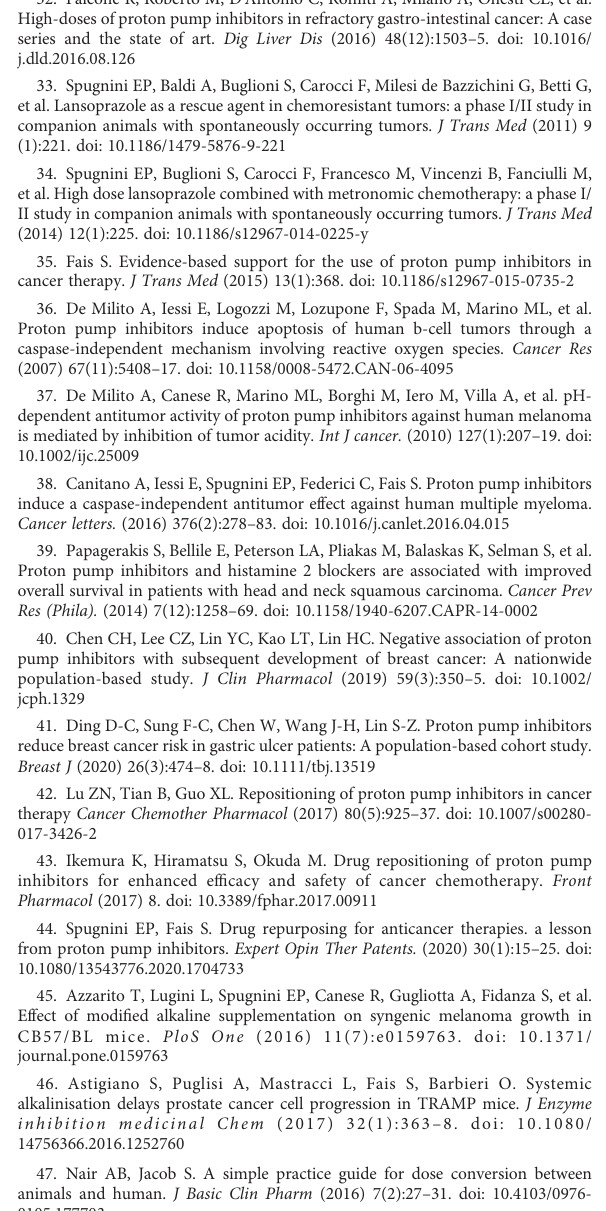
8. Bottomley PA, Grif fi ths JR. Handbook of magnetic resonance spectroscopy. In: Vivo: MRS theory, practice and applications . USA: Wiley